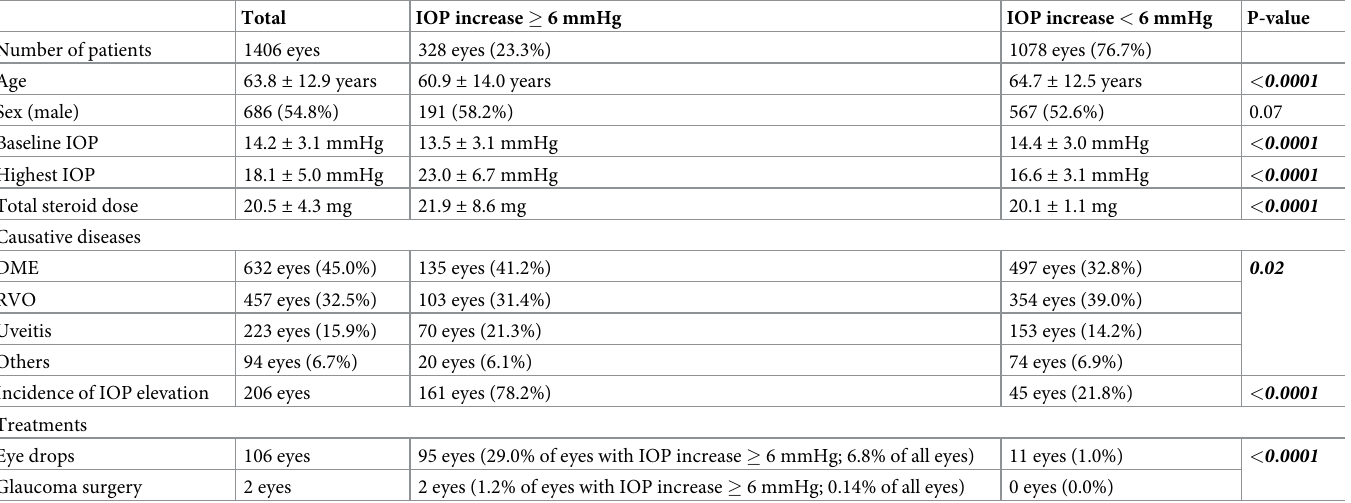
Table 3. Analyses of IOP increase � 6 mmHg.